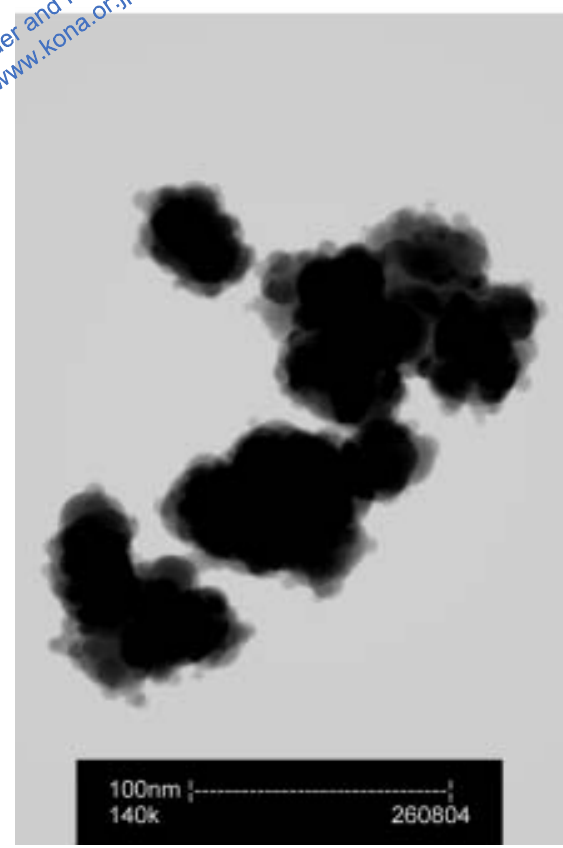
Fig. 2 Two-dimensional TEM-style projection of a sample parti- cle taken from premixed laminar ethylene flame simula- tion (Provided by Neal